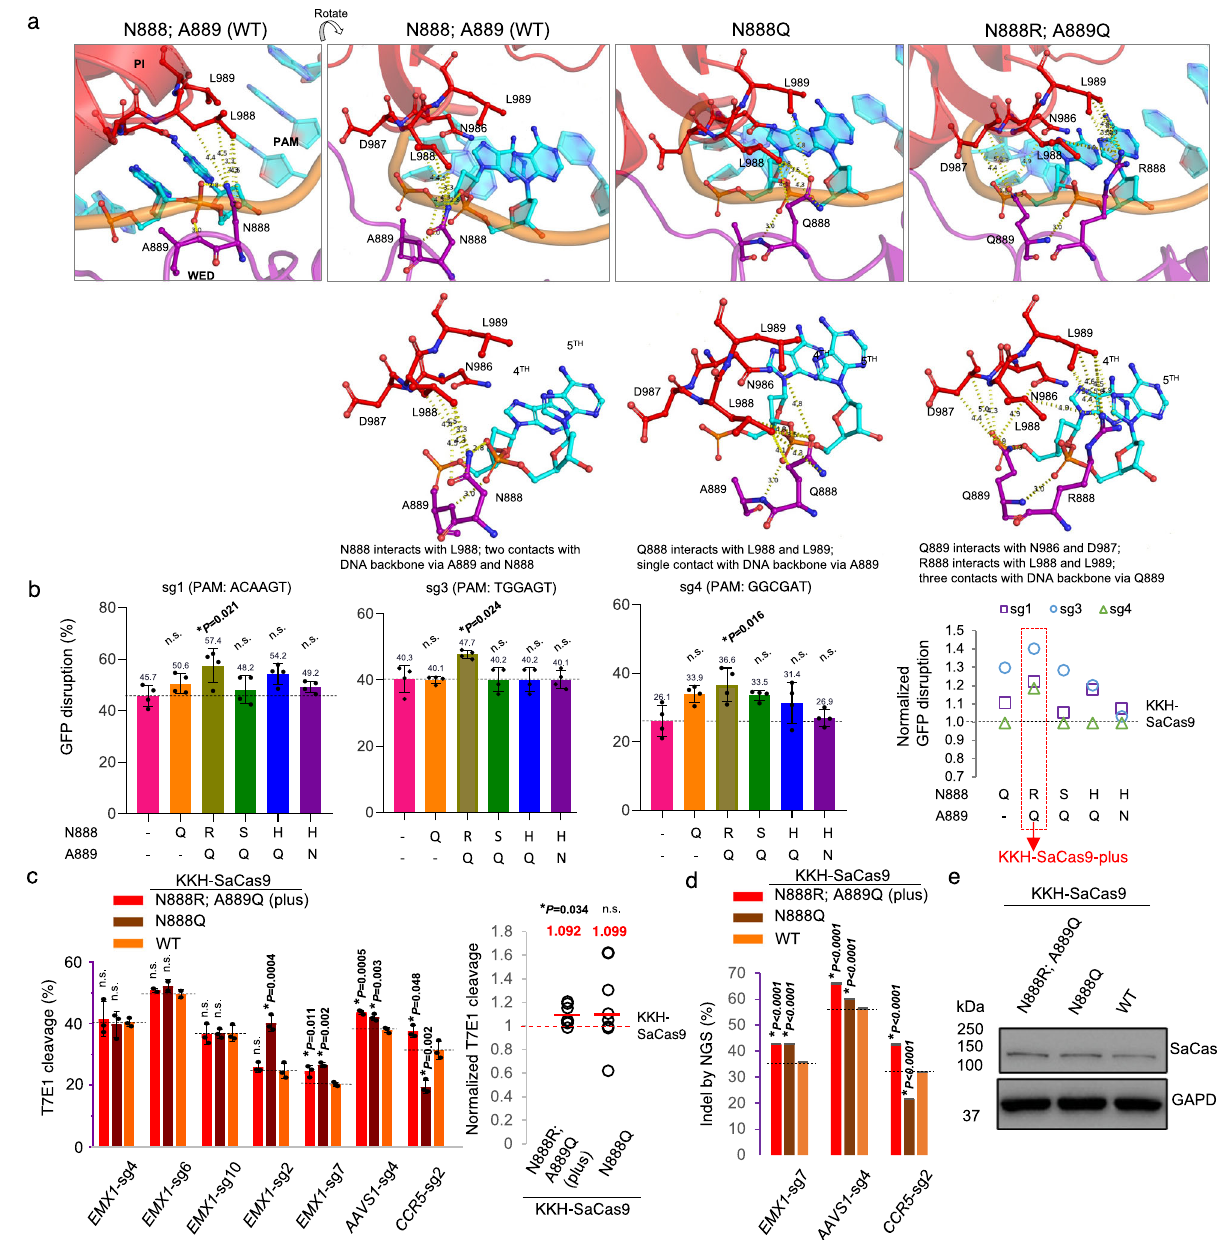
Fig. 4 Structure-guided engineering improves the editing ef fi ciency of activity-enhanced KKH-SaCas9 variants. a Molecular modeling of N888Q and N888R/A889Q mutations on WED domain of SaCas9 depicts their increased interactions with residues on its PI domain and the DNA backbone. b KKH- SaCas9 variants carrying mutations on residues 888 and/or 889 were individually constructed and characterized using GFP disruption assays with three independent sgRNAs at 5 days post infection. The mean editing ef fi ciency + / − SD (error bar) of the KKH-SaCas9 variants ( n = 4 biologically independent samples) was measured as the percentage of cells with depleted GFP fl uorescence using fl ow cytometry. Statistical signi fi cance was analyzed by one-way ANOVA with Tukey ’ s test. The P- values of 0.016 – 0.024 indicate the comparisons with the wild-type variant's activity. c , d Assessment of KKH-SaCas9 variants ’ on-target editing with sgRNAs targeting endogenous loci. The percentage of sites with indels was measured using a T7 endonuclease-I (T7E1) assay in ( c ) and deep-sequencing assay in ( d ). Mean and standard deviation are shown for the loci tested. Each locus was measured in n = 3 biological independent samples. Statistical signi fi cance was analyzed by one-way ANOVA with Tukey ’ s test. The P- values of <0.0001 – 0.048 indicate the comparisons with the wild-type variant ’ s activity. The ratios of the on-target activity of KKH-SaCas9 variants with N888Q and N888R/A889Q mutations to the activity of KKH-SaCas9 were determined, and mean for the normalized activity is shown and highlighted by a red line ( n = 7, one-sample t-test). n.s. indicates not signi fi cant. e Western blot analysis on protein expression of the KKH-SaCas9 variants. This experiment was performed once. The source data for fi gures ( b – e ) are provided as a Source Data fi le.